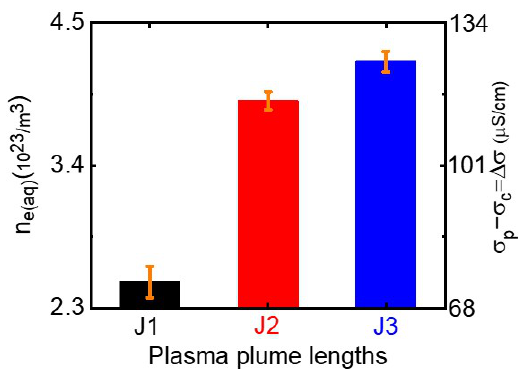
Figure 6. Aqua electron densities of plasma-treated AgNO 3 -TSC-DW treated for 10 min with the J1, J2, and J3